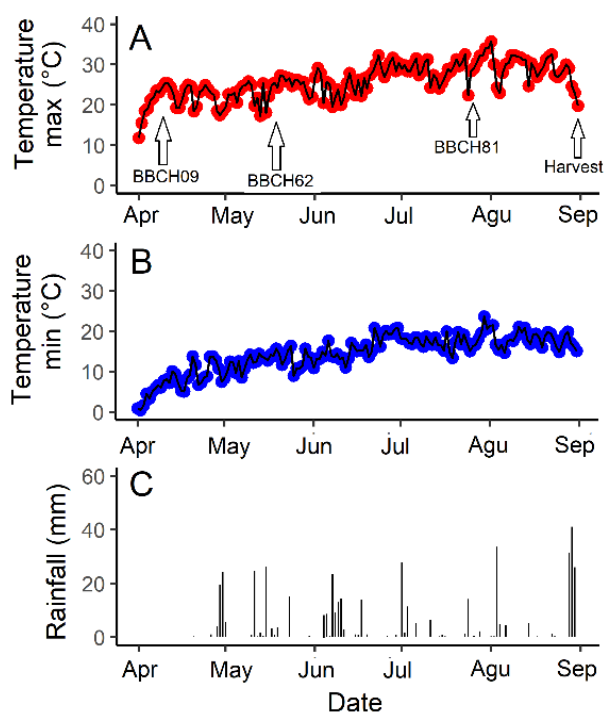
Figure 1. Dynamic of environmental conditions during spring 2020. In ( A ) the maximum daily temperature while in ( B ) the minimum daily temperatures are shown. In ( C ) daily rainfall is presented. In ( A ) some of the key phenological stages are included (phenological screening is shown in Supplementary Table S1).